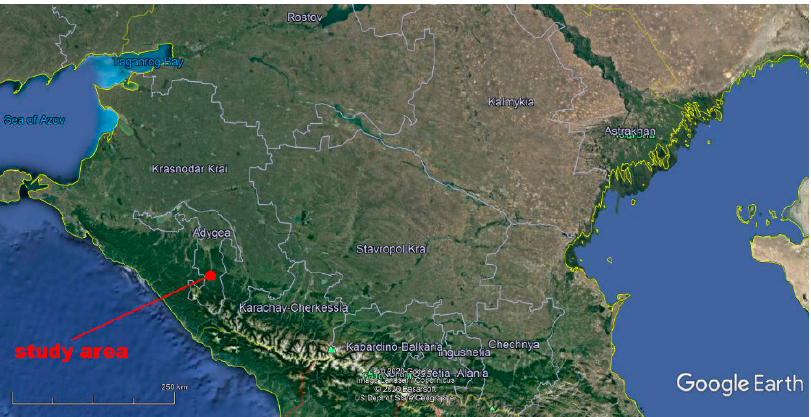
Figure 1. Geographical location of the study area (the view provided by Google Earth Engine).